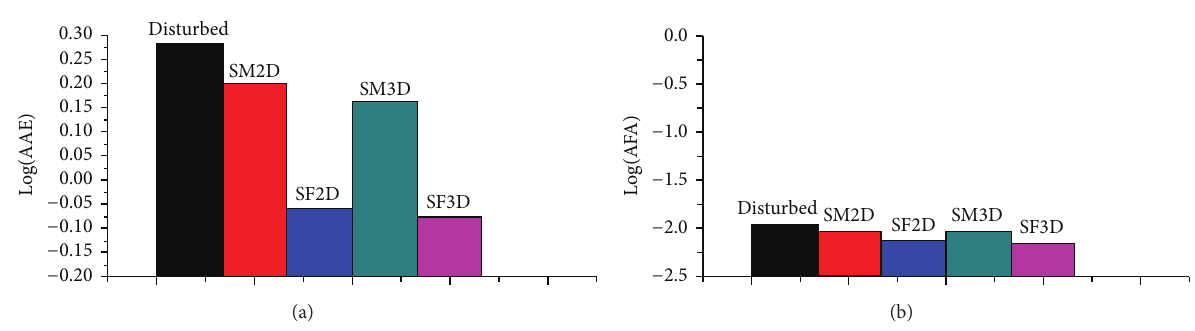
Figure 10: Errors when we recover human data from MR scanner corrupted with Gaussian noise having zero mean and 𝜎 = 0.0001 by using the four median filtering methods: (a) Log (AAE) error and (b) Log (AFA) error.